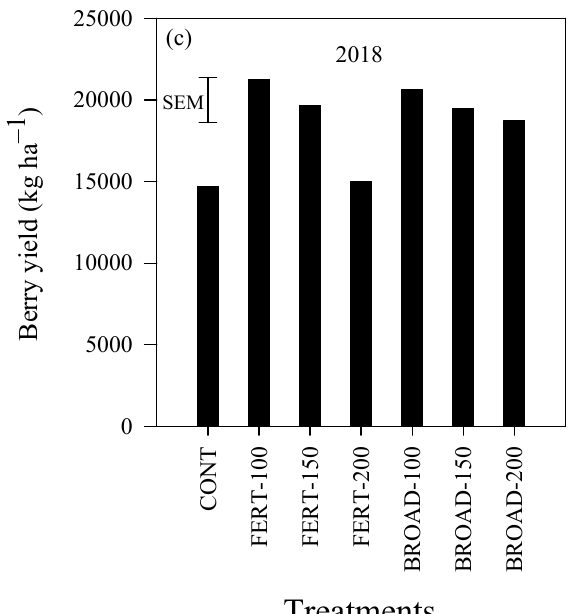
Figure 6. Total berry yield (kg ha − 1 ) in ( a ) 2016, ( b ) 2017 and ( c ) 2018 with annual applications of N through fertigation (FERT-100, 100%; FERT-150, 150%; FERT-200, 200%) and broadcast (BROAD-100, 100%; BROAD-150, 150%; BROAD-200, 200%) methods to highbush blueberry ( Vaccinium corymbosum ). Error bars represent the standard errors of the means (SEM) for comparing all values (n = 28 and df =